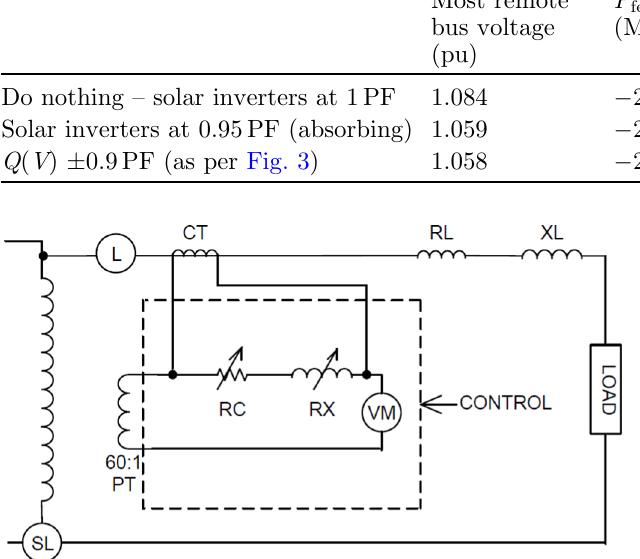
Fig. 5. Voltage pro fi les starting from the 132/22kV substation through to the most “ remote Bus ” for the combination of the Q ( V ) and LDC options and household solar power levels from zero to